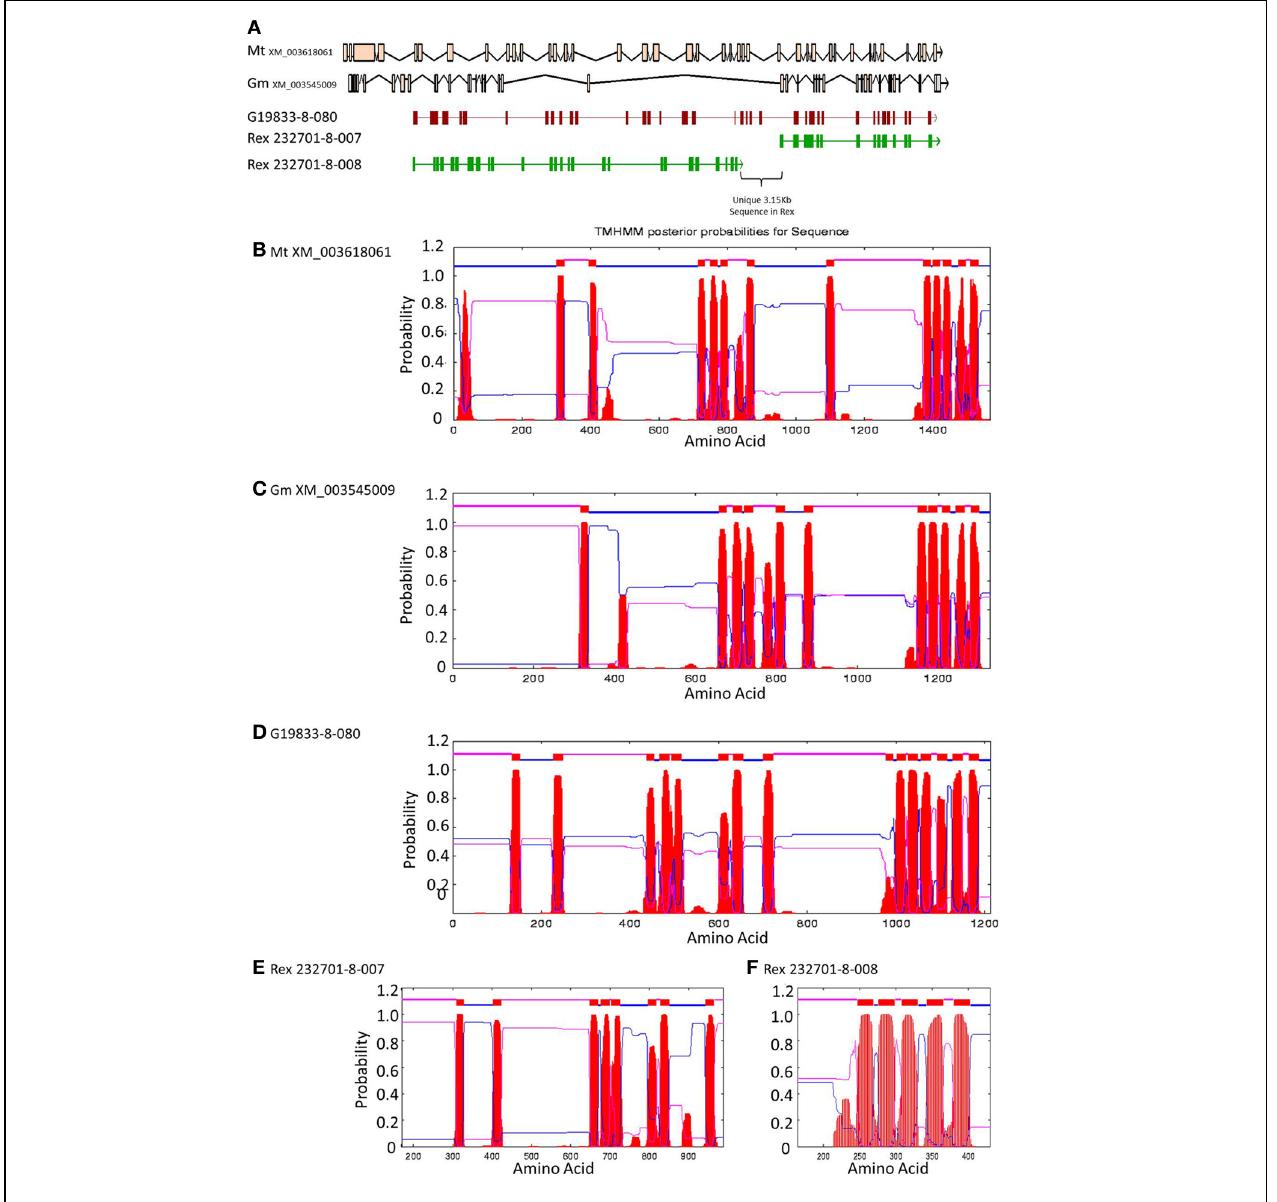
FIGURE 6 | Comparisons of Niemann Pick-like genes from G. max , M. truncatula , and G19833 P. vulgaris and genes in the same locus in OAC-Rex. (A) The exon/intron structures of the genes. Secondary structure